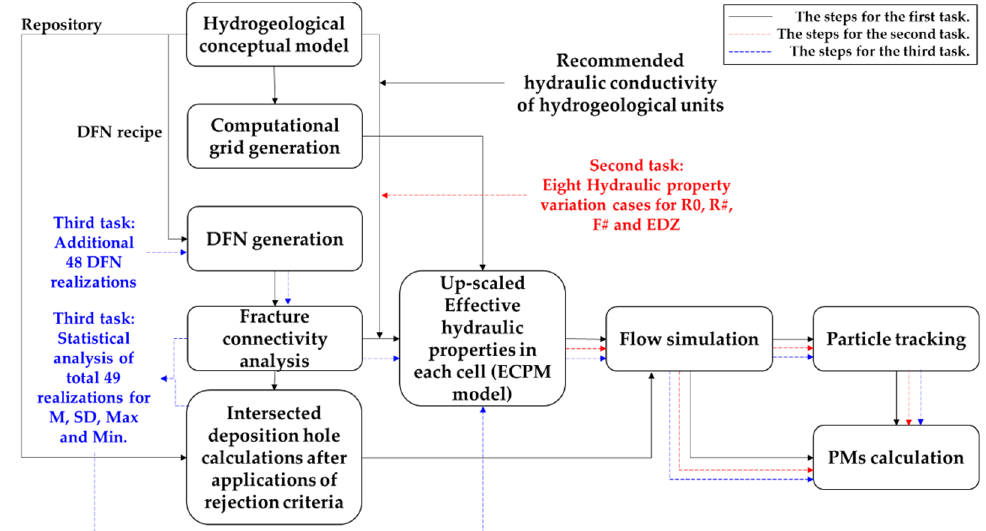
Figure 4. The main steps involved in the workflow are to simulate flow and advective transport and calculate the PMs for three tasks in this study.